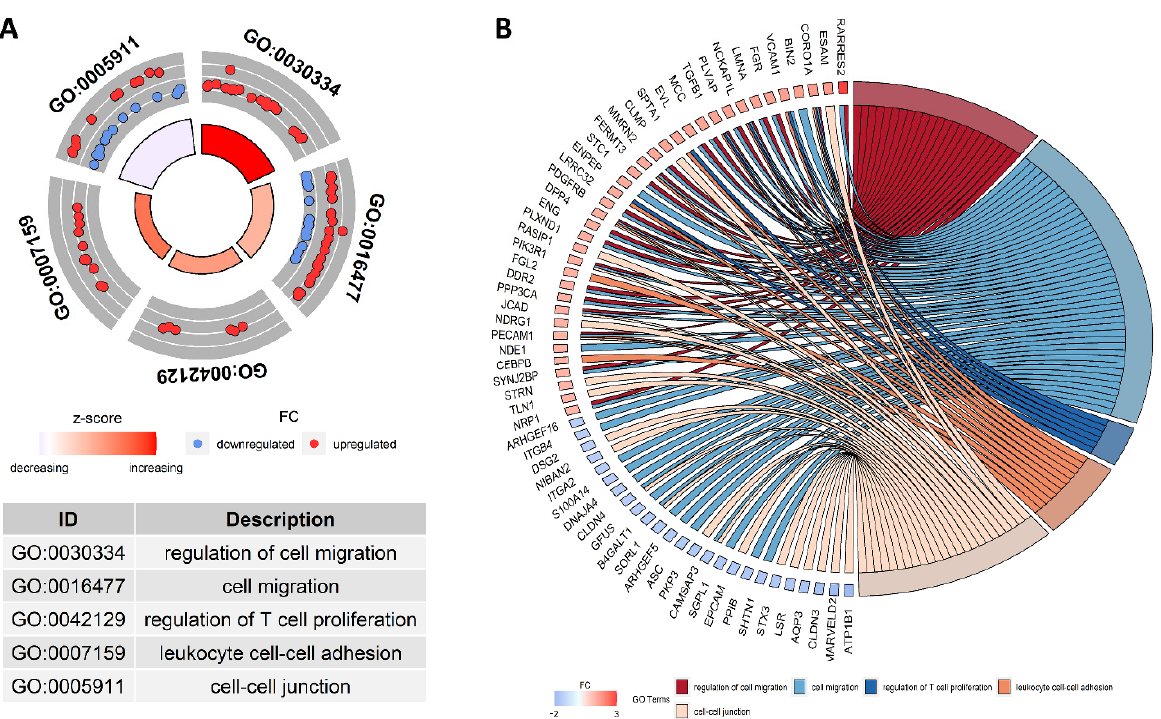
Figure 3. Visualization of the differentially regulated proteins (DRPs) determined to be statistically significant and their enrichment in the ontology terms detected by g:Profiler tool. ( A ) The circular plot illustrates the five most interesting GO biological processes enriched by DRPs. The outer track shows upregulated (red dots) and downregulated DRPs (blue dots) annotated in the particular GO terms. The inner track depicts the ratio of up- and downregulated proteins engaged in GO terms. A more intense red color shows the greater involvement of overexpressed proteins. ( B ) The circular